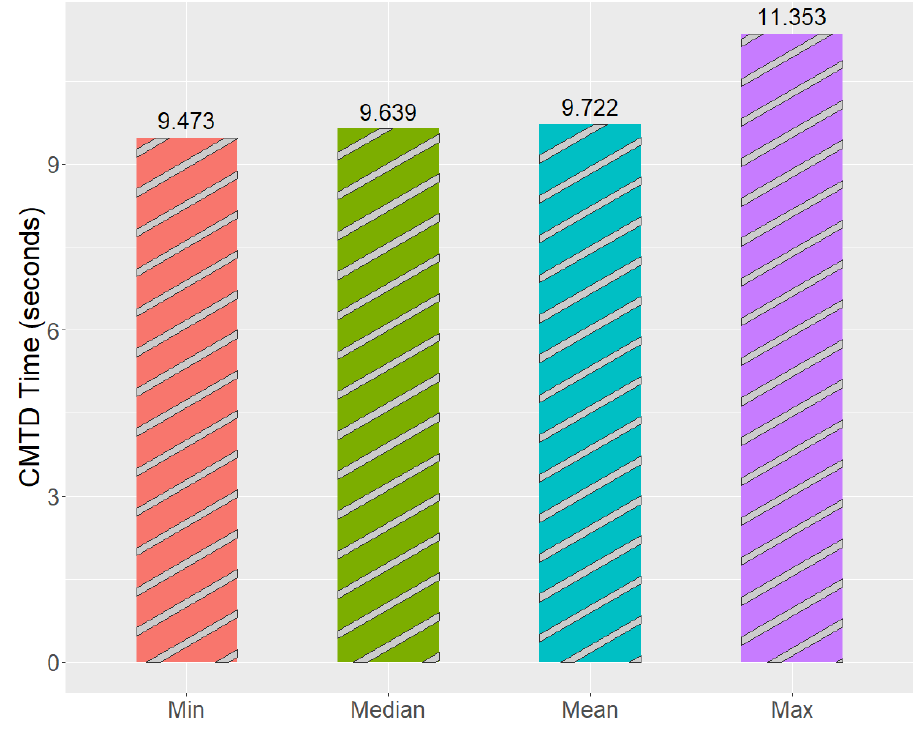
Figure 10. MTD Test